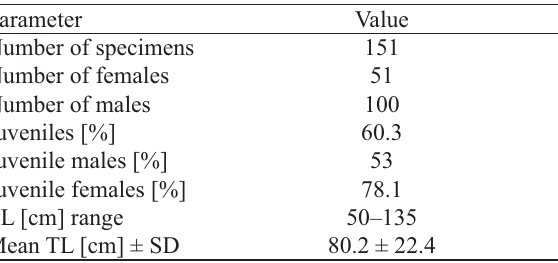
General parameters characterising the studied sample of Mustelus punctulatus from North Adriatic